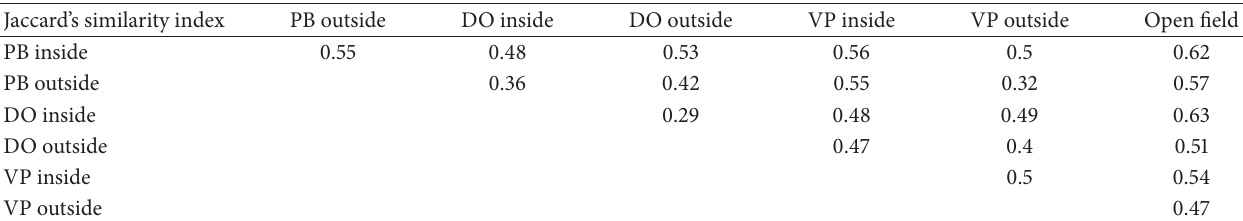
Table 3: Half matrix of dissimilarity of species composition among inside and outside crown zones of the trees and the open field. PB: P. biglobosa ; DO: D. oliveri ; VP: V. paradoxa . Jaccard’s similarity